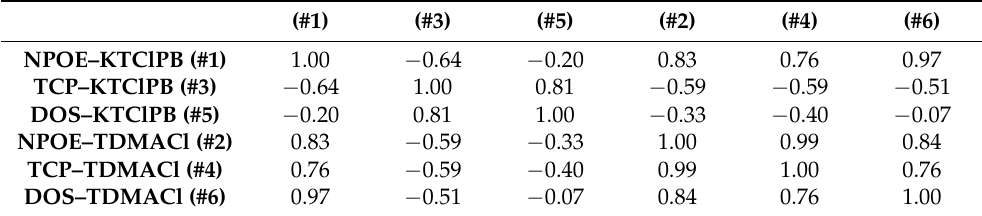
Table 4. Pearson coefficients for correlation between each pair of